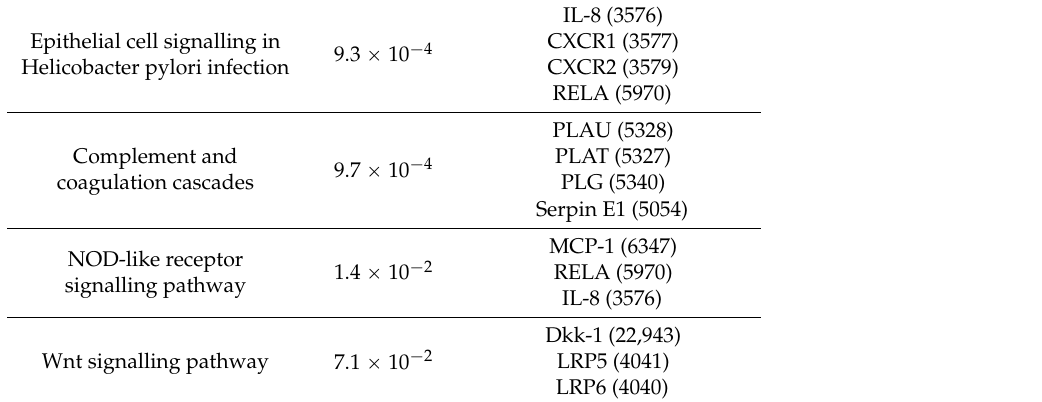
Table 4. Pathway analysis by the David database of high abundance analytes secreted by hepatocytic differentiated hbmMSC and hsubMSC and 10 potential interaction partners as predicted by the STRING database (input of analytes as summarised in Tables S3 and S4). Associated KEGG-pathways with p -values of significance as well as analytes involved are